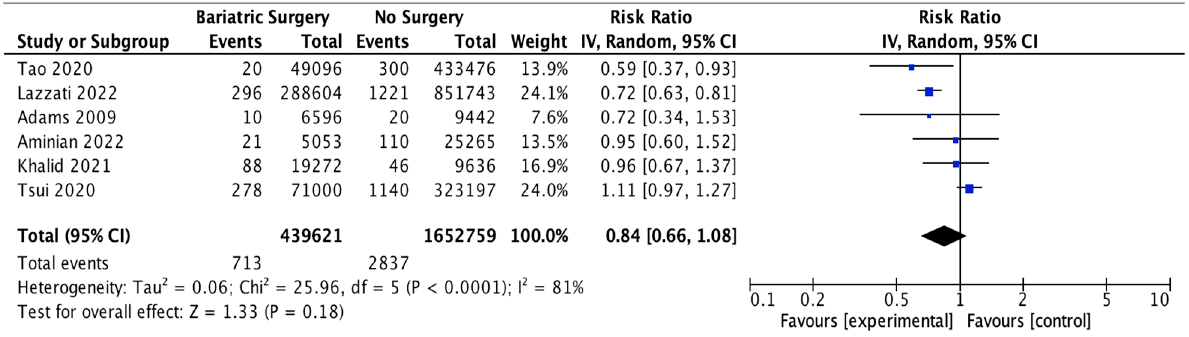
Figure 16. Thyroid cancer incidence [38–40,42,43,49].